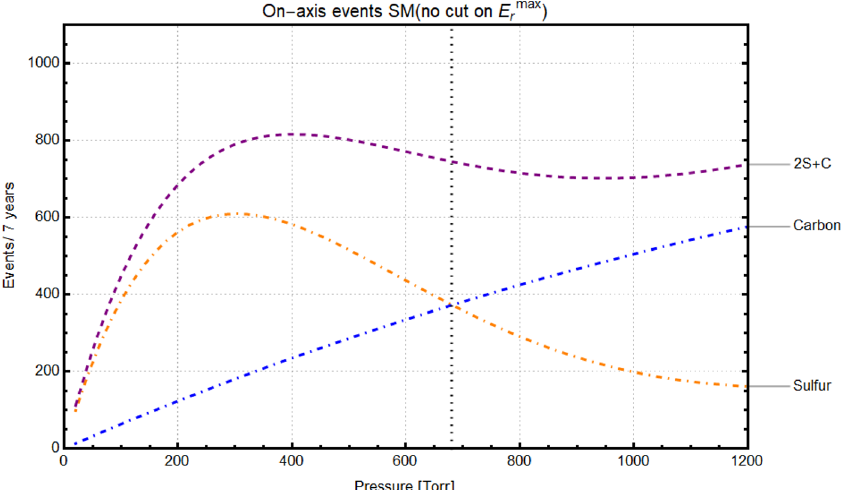
Figure 1. Expected number of CE ν NS events in ν BDX-DRIFT as a function of the pressure configuration (in Torr) for a data-taking period of 7 years. The vertical grey line shows the pressure value where the Carbon contribution overtakes the Sulfur one. The number of events is computed in the SM and, for illustrative purposes, we do not impose any cut on the maximum recoil energy.